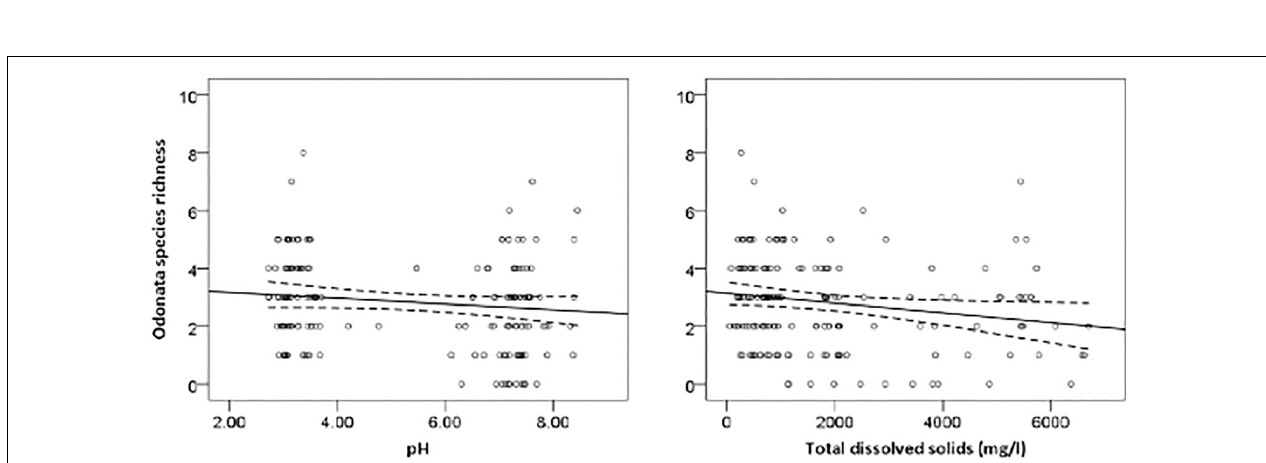
FIGURE 4 | Responses of Odonata species richness to water temperature ( ◦ C) and vegetation cover (%). Based on GLMs, scatter plots have 95% confidence intervals (dashed) on the regression (solid) line.